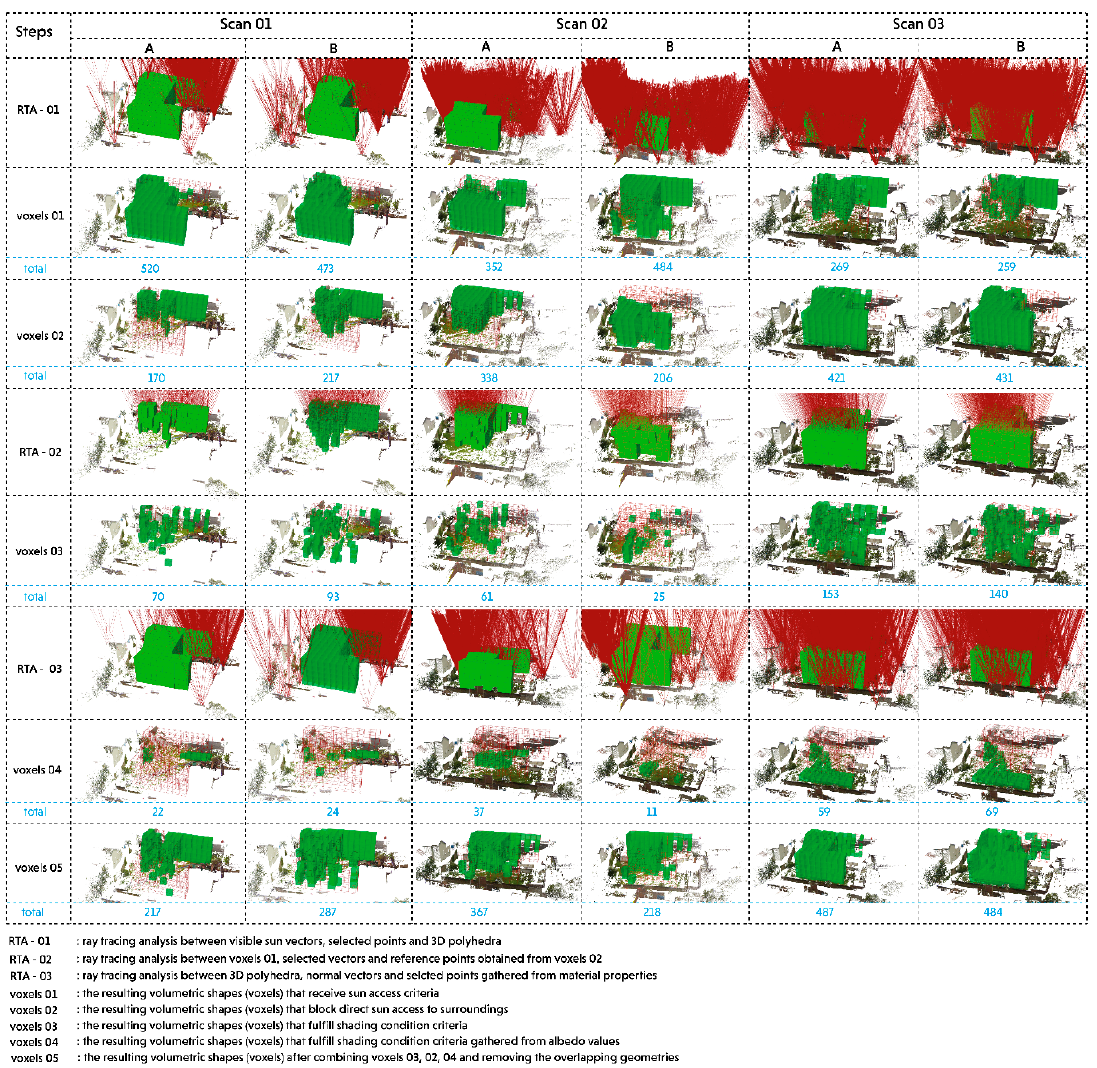
Figure 13. The geometric configuration of subtractive shading envelopes based on sequential steps of design simulation.